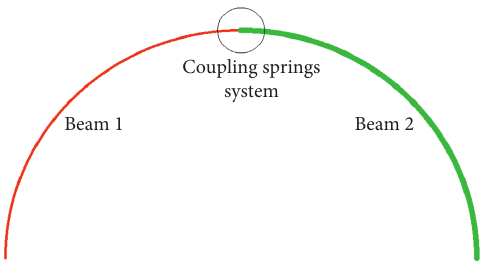
Figure 6: Cross-section mutation structure. Table 6: Comparison of the first 10 natural frequencies of the cross-section mutation structure under different boundary conditions. C-C S-S F-F Present FEM Present FEM Present